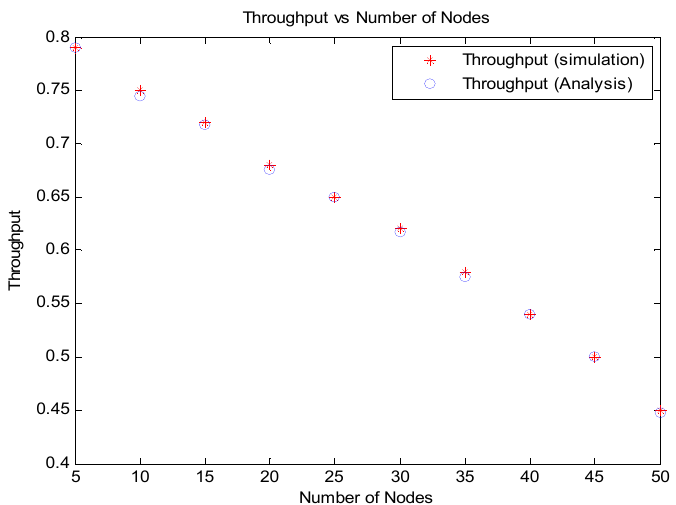
Figure 10. Throughput of PCMAC vs. number of nodes.